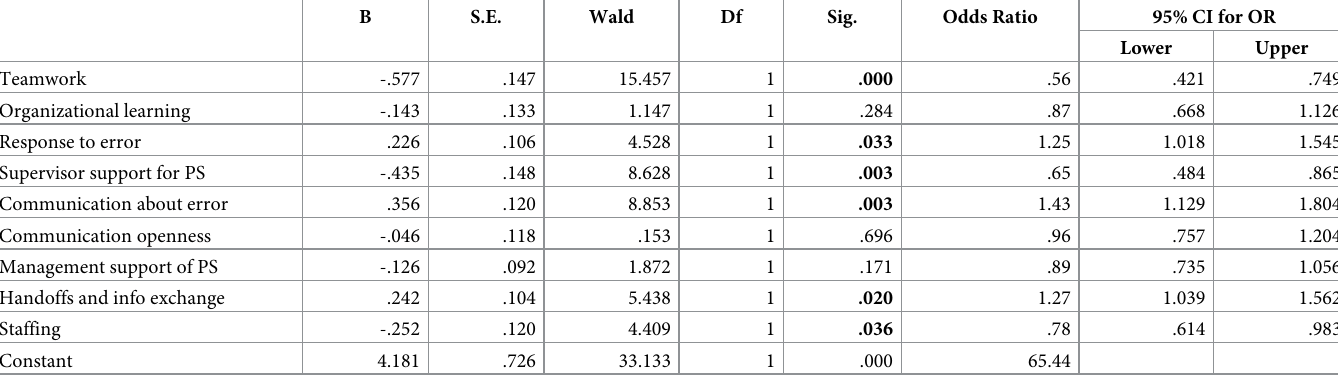
Table 6. Logistic regression predicting adverse event reporting in the healthcare